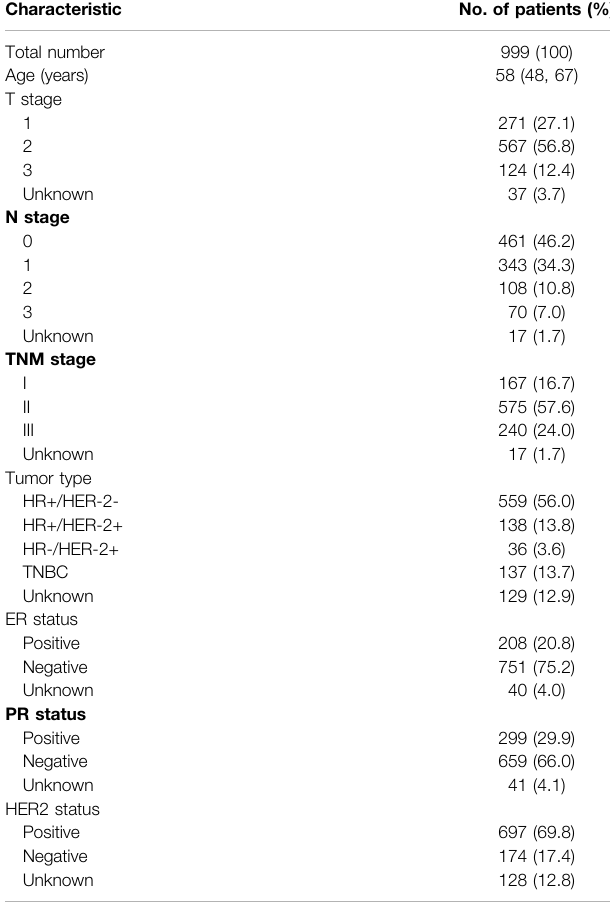
TABLE 1 | Patient demographics and clinical